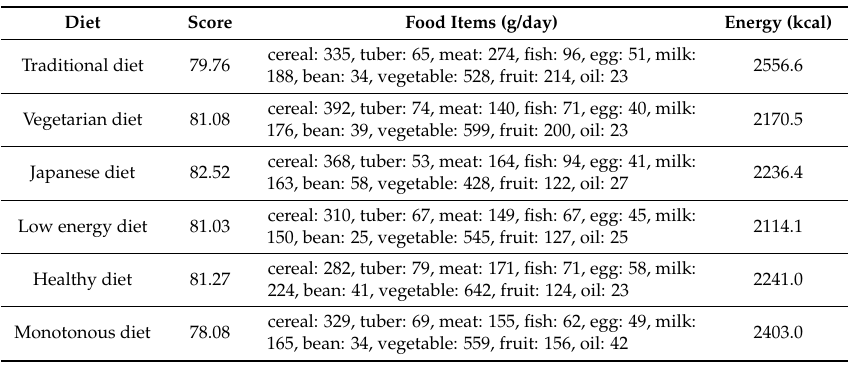
Table 5. Evaluation of the different dietary patterns